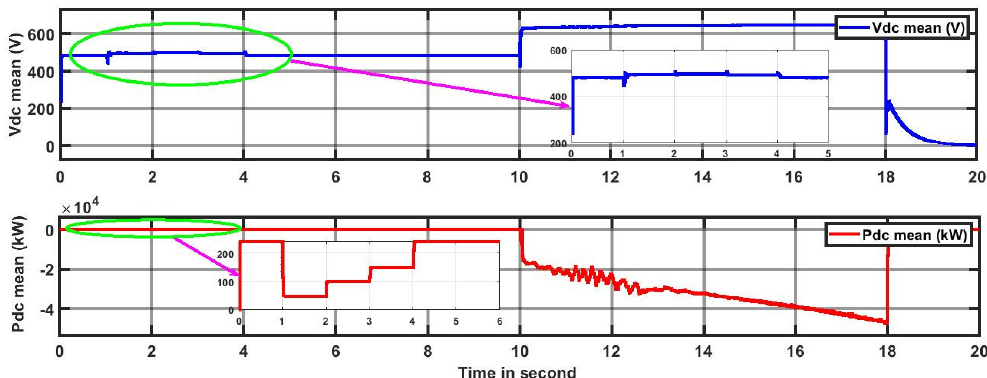
Figure 11. P dc and V dc grid-connected PV inverter power conversion signal with four steps of irradiance.